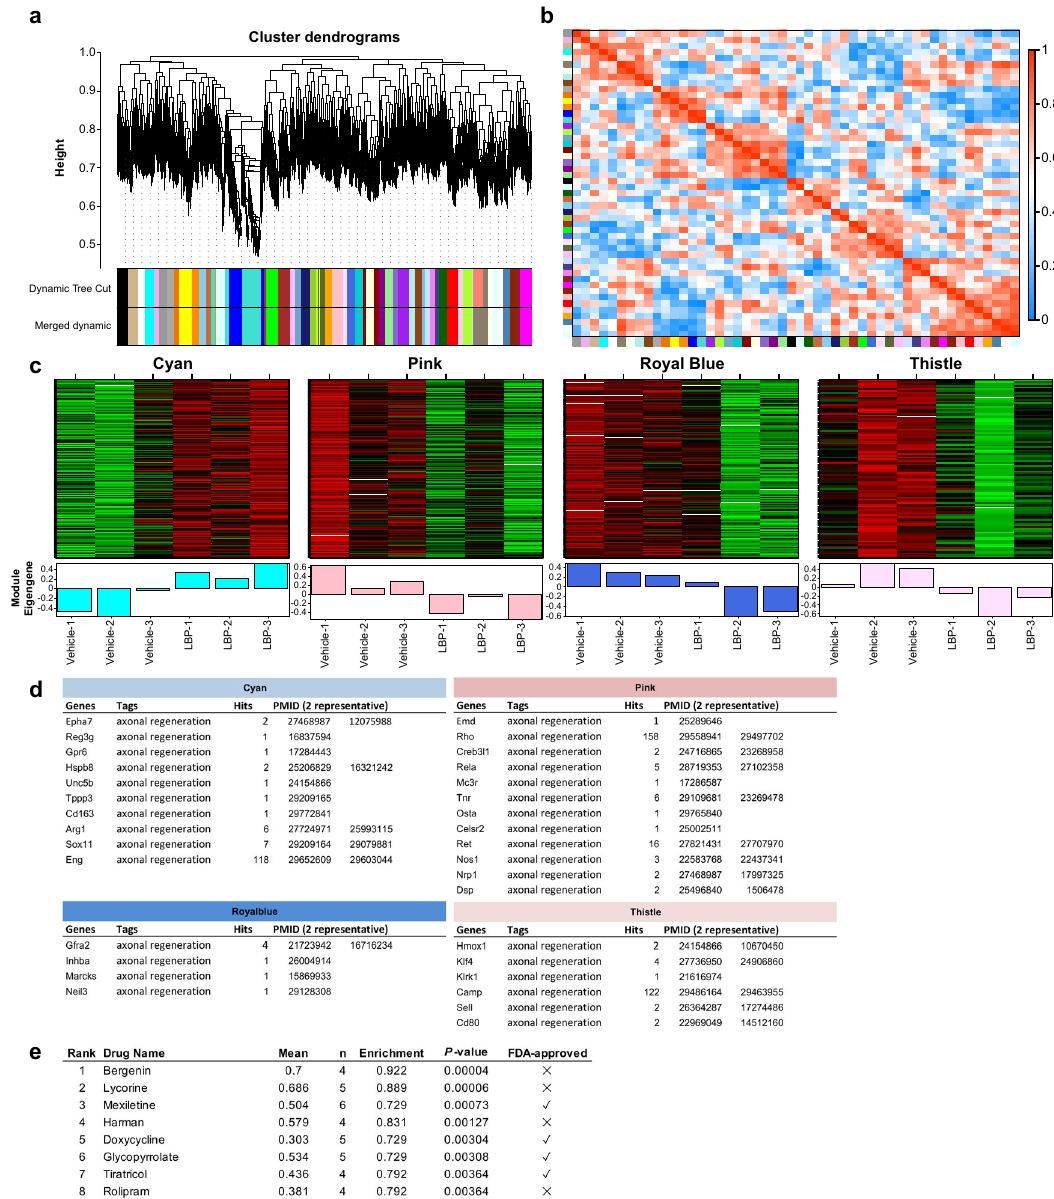
Fig. 5 In silico screening of FDA-approved small molecule using LBP gene expression pro fi le signatures. a , b Weighted gene correlation network analysis identi fi ed expression modules across the microarray datasets represented by 50 different colors. Red indicated strong correlations and blue indicated weak or no correlations in ( b ). c Four key co-expression modules which were strongly associated with the core signaling network induced by LBP. Heatmap showing the scaled expression of genes (rows) across each sample (vehicle- and LBP-treated dorsal root ganglions) within the four modules. Red indicated up-regulation of genes while green indicated down-regulation of genes. d Every single gene within each module was query in PubMed database using keywords such as neuronal regeneration, axon regeneration and nerve injury. LBP-induced expression of RAGs including Arg1 , Sox11 and Tppp3 (in cyan module) and inhibited the expression of growth-inhibitory molecules including Rho , Tnr (in pink module), and Klf4 (in thistle module). e LBP-induced gene expression pro fi le signatures (both up- regulated and down-regulated) were used to query Connectivity Map database, and eight small molecules (ranked by their permutation P -values) with their induced gene expression pro fi les closely resemble to LBP were identi fi ed for subsequent experimental validation based on connectivity and speci fi city axons but not spared axons 48 , recombinant CTB conjugated with the most distal RGC projection site in the SC (Fig. 8f). The fl uorescent intensity of CTB-labeled regenerating RGC axons Alexa Fluor 488 (CTB-488) was intravitreally injected to anterograde were quanti fi ed in each subcortical visual target area (Fig. 8g). In label the intact RGC axons two days before the ONC 47 . Immediately stark contrast, no CTB-labeled regenerating RGC axons were after the ONC, glycopyrrolate was intravitreally injected into the detected in the subcortical visual targets of vehicle-treated mice injured eye, and CTB-555 was intravitreally injected to trace the (Supplementary Fig. 12). regenerating RGC axons one day after the ONC. Optic nerves To ensure that the CTB-positive RGC axons we observed in the were harvested three days after ONC and examined histologically optic nerves and major subcortical visual targets were regenerating (Supplementary Fig. 13a). CTB-488-positive axons were only